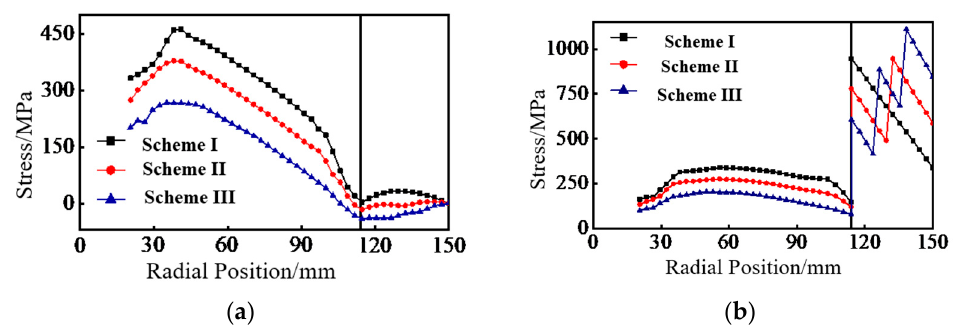
Figure 8. Stress curve of the flywheel at maximum speed. ( a ) Radial stress curve; ( b ) hoop stress curve. stress curve.